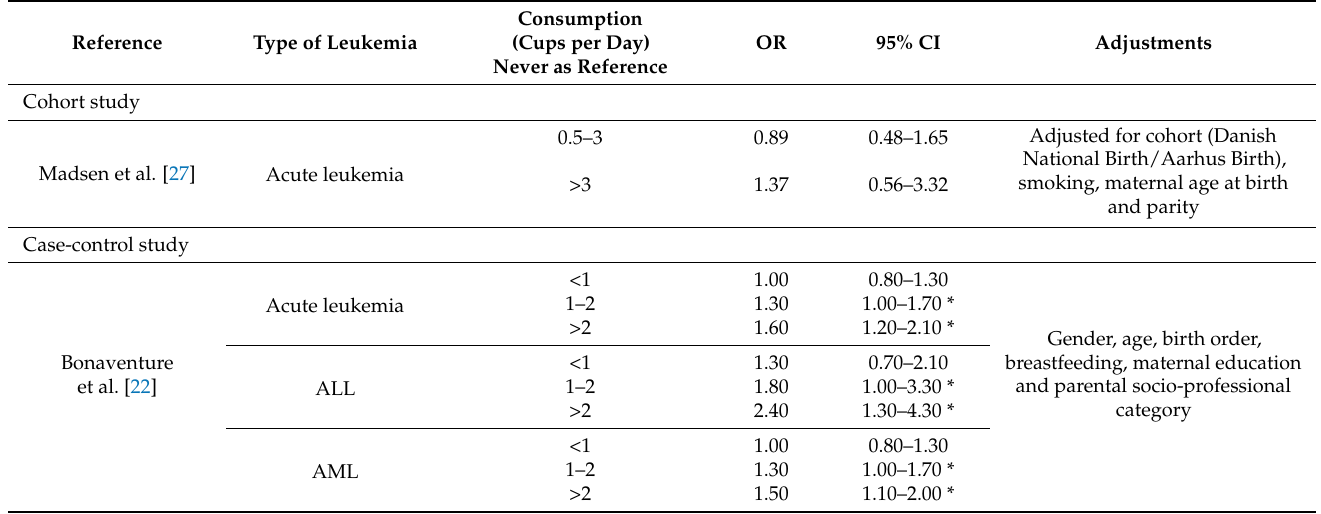
Table 6. Overview of the association between maternal coffee consumption during pregnancy and risk of acute leukemia in